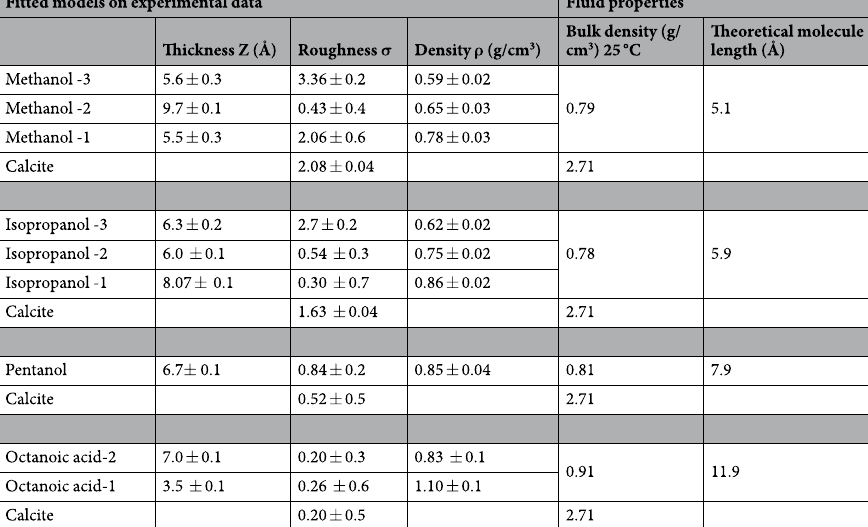
Table 1. The tabulated parameters are obtained from fitting the reflectivity data with box models. For models with more than one layer, the layer closest to the calcite surface is indexed 1 (e.g. Methanol-1). The density for calcite (2.71 g/cm 3 ) and helium (0.03 g/cm 3 ) were kept fixed during the fitting procedure, and their thicknesses were infinite. Error estimates were obtained for every parameter by varying the parameter until the χ based R-value is changed by 5% 70,71 . The method does not reveal correlations between the parameters. On the right side, theoretical bulk density and the molecular length of the molecules are given for